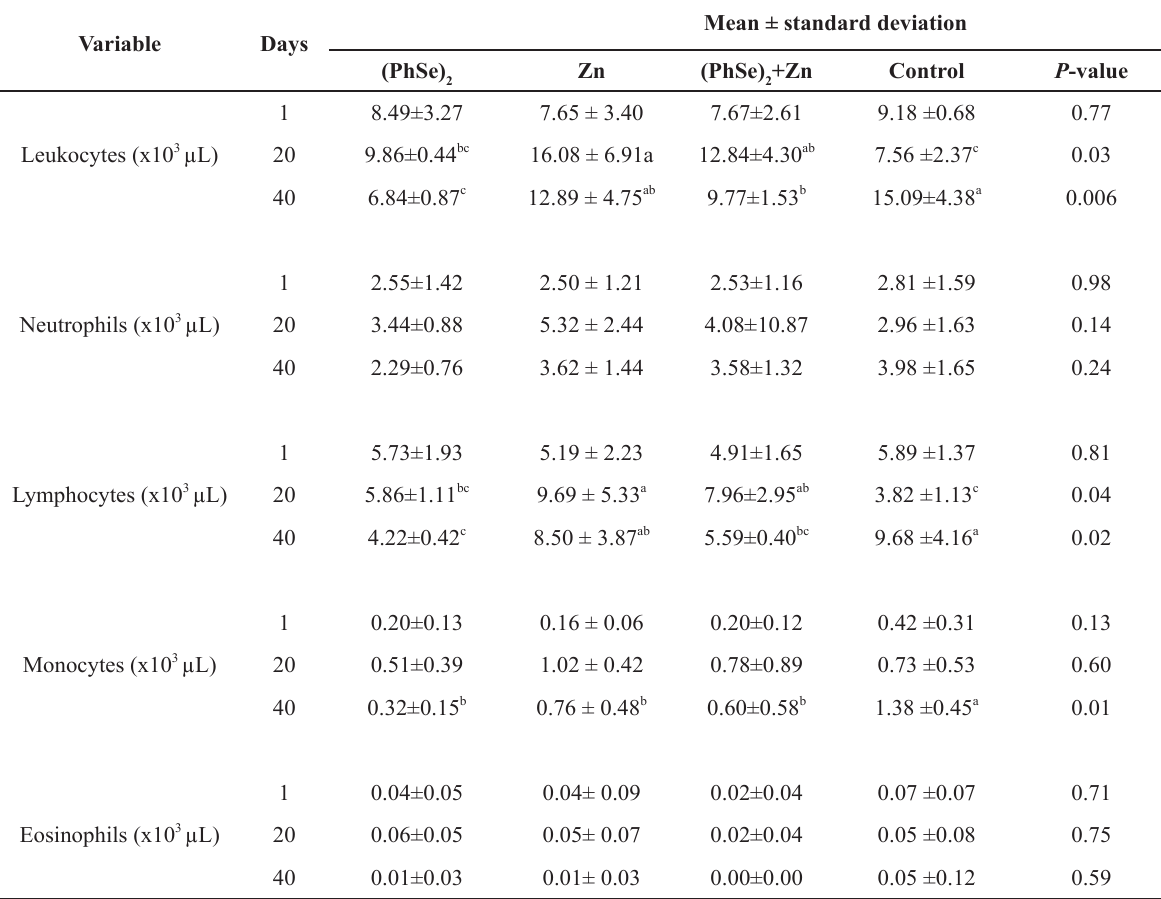
Mean and standard deviation of blood components for each group at the day 1, 20 and 40 of the experiment. Different letters mean significant difference between